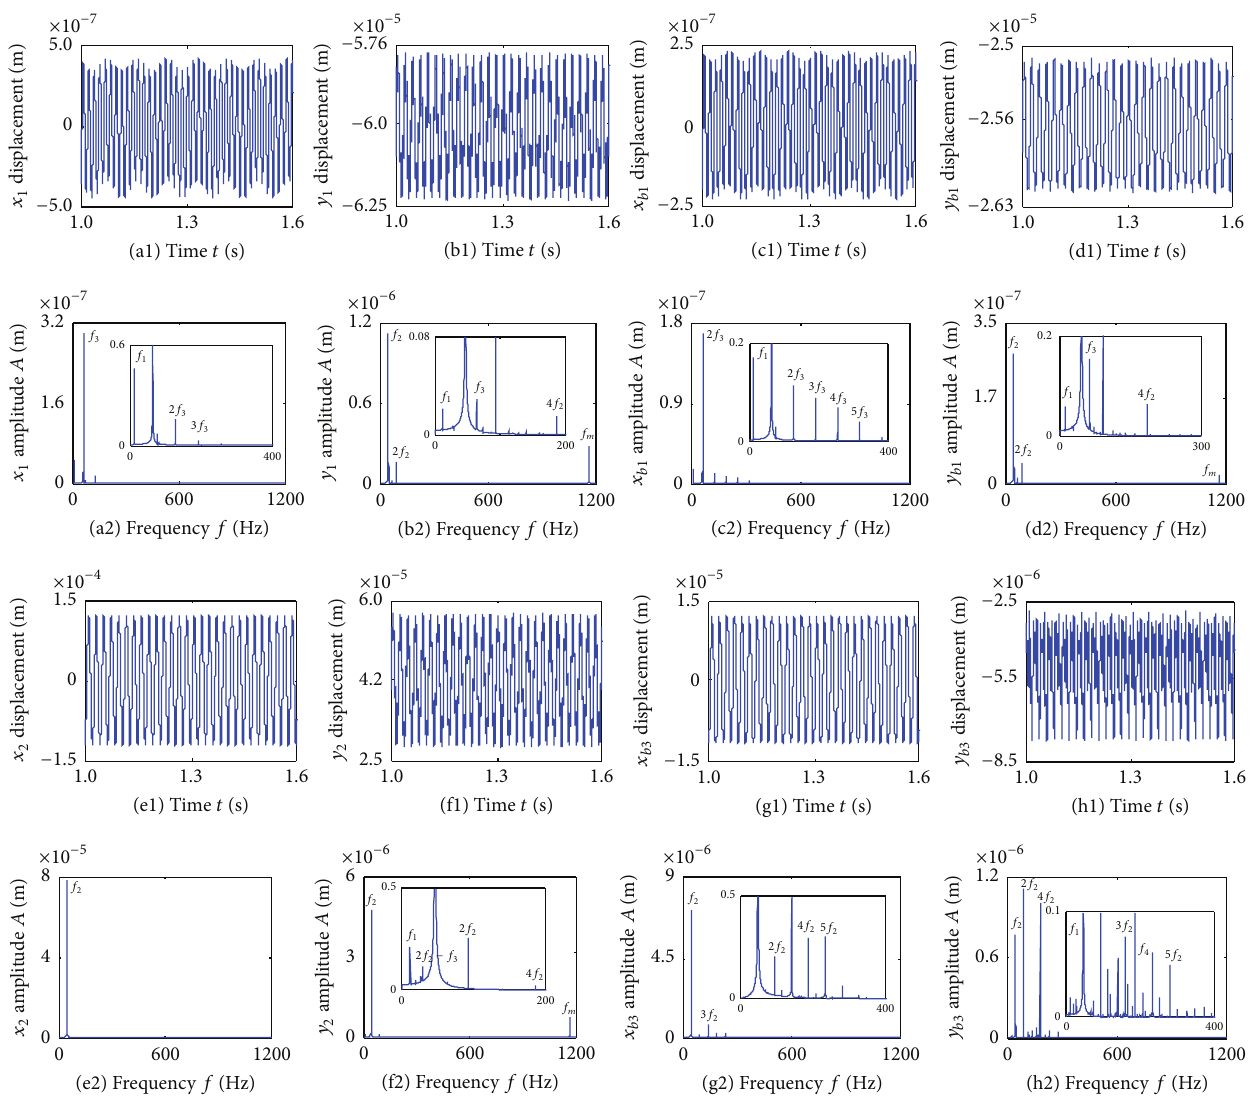
Figure 6: Lateral waveform and frequency spectrum at 𝑛 1 = 700 r/min, 𝜌 1 = 2.0 × 1 0 −6 m, and 𝜌 2 = 2.0 × 1 0 −5 m.